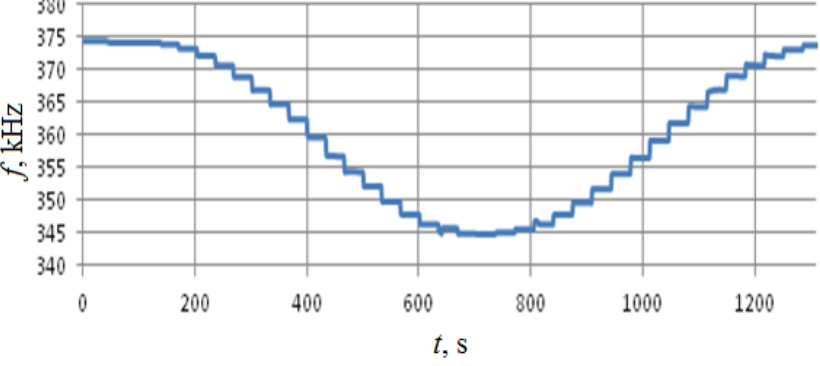
Figure 11. Test results for rotations around the z -axis.